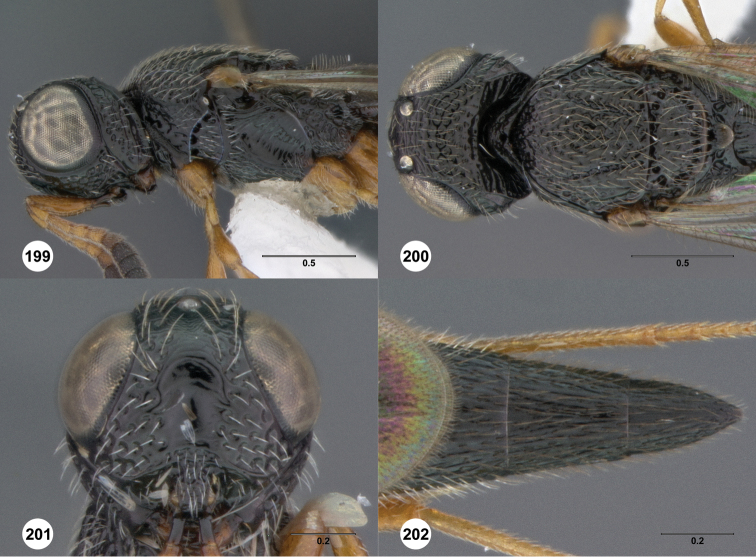
Oxyscelio mystacis sp. n., paratype female (OSUC 227614) 199 Head and mesosoma, lateral view 200 Head and mesosoma, dorsal view. Holotype female (OSUC 368224) 201 Head, anterior view 202 Metasoma, dorsal view. Morphbank66